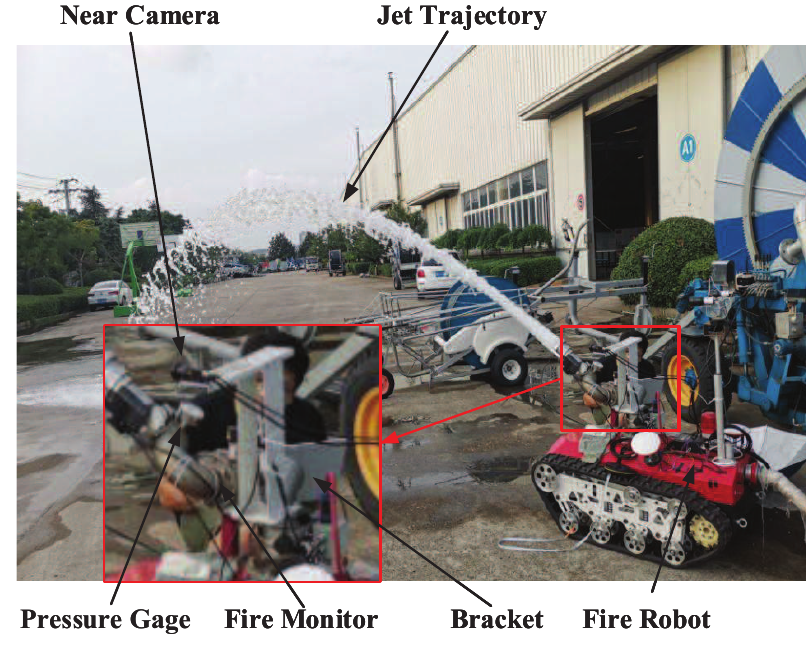
Figure 7. Structural diagram of the experimental